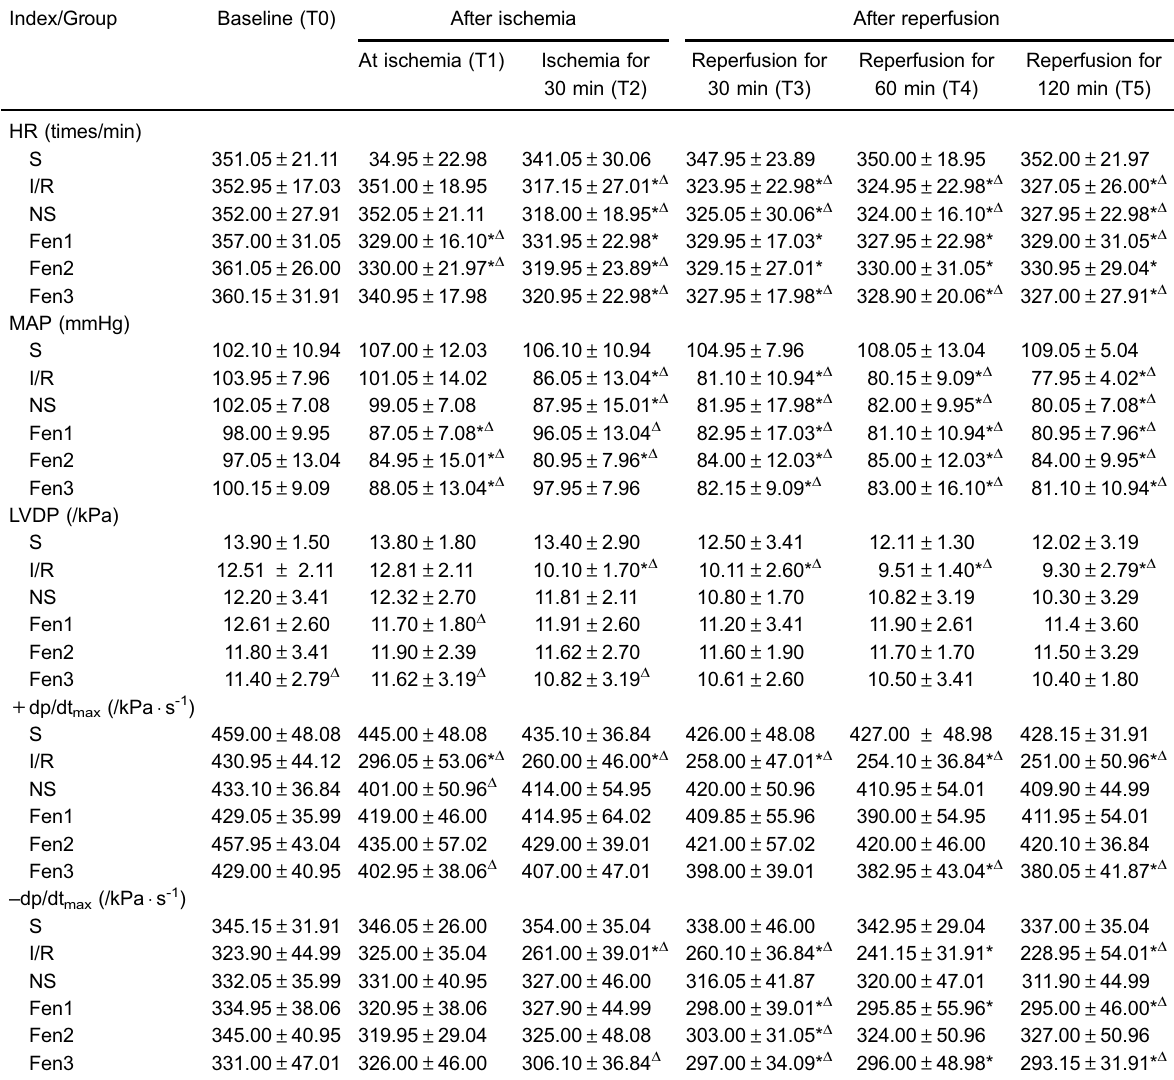
Table 1. Heart function index changes in each group (n=20/group) at different time